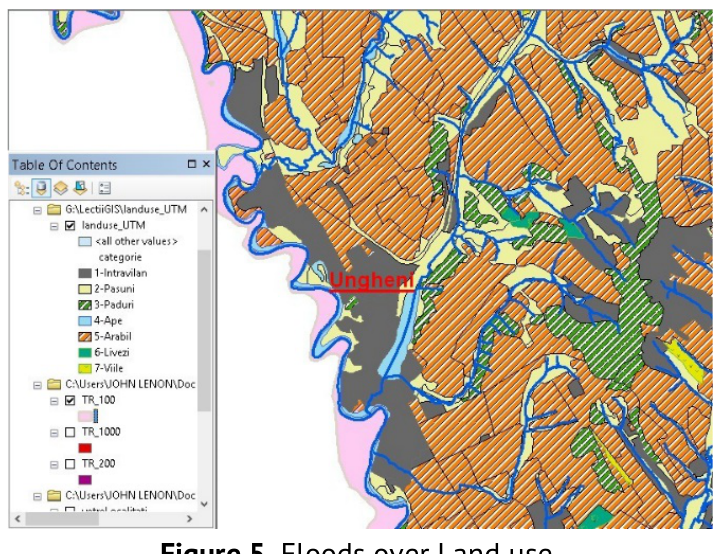
Figure 5. Floods over Land use. Source: [11].